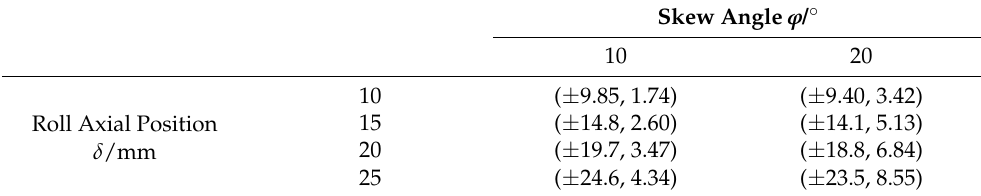
Figure 4. Schematic diagram of the experimental machine. Table 2. ( Z B , Y B ) coordinates in each condition. Table 2. ( Z B , Y B ) coordinates in each condition.